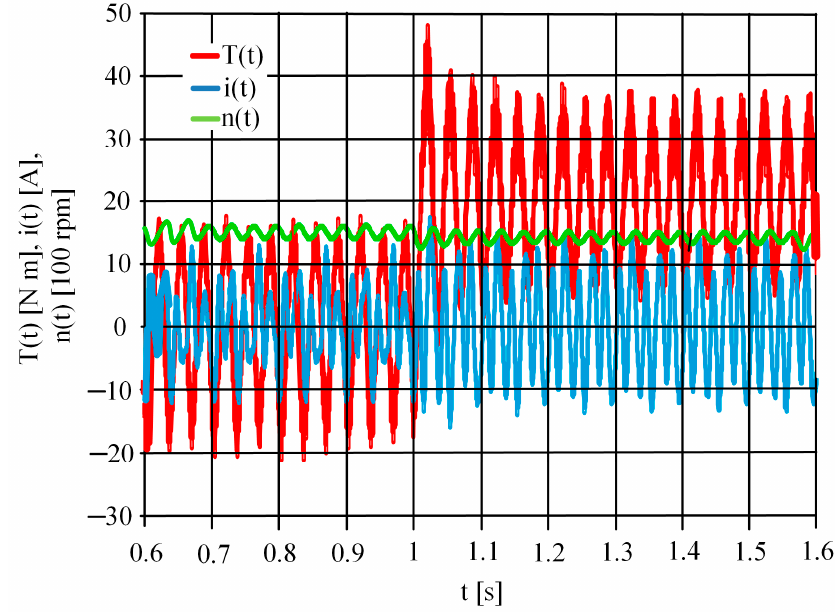
Figure 8. Electromagnetic torque, rotational speed and stator current waveforms for motor2, f m = 20 Hz, φ ih = 0 ◦ , a negligible load moment of inertia and a step change of load torque from 0 to 100% of T rat .